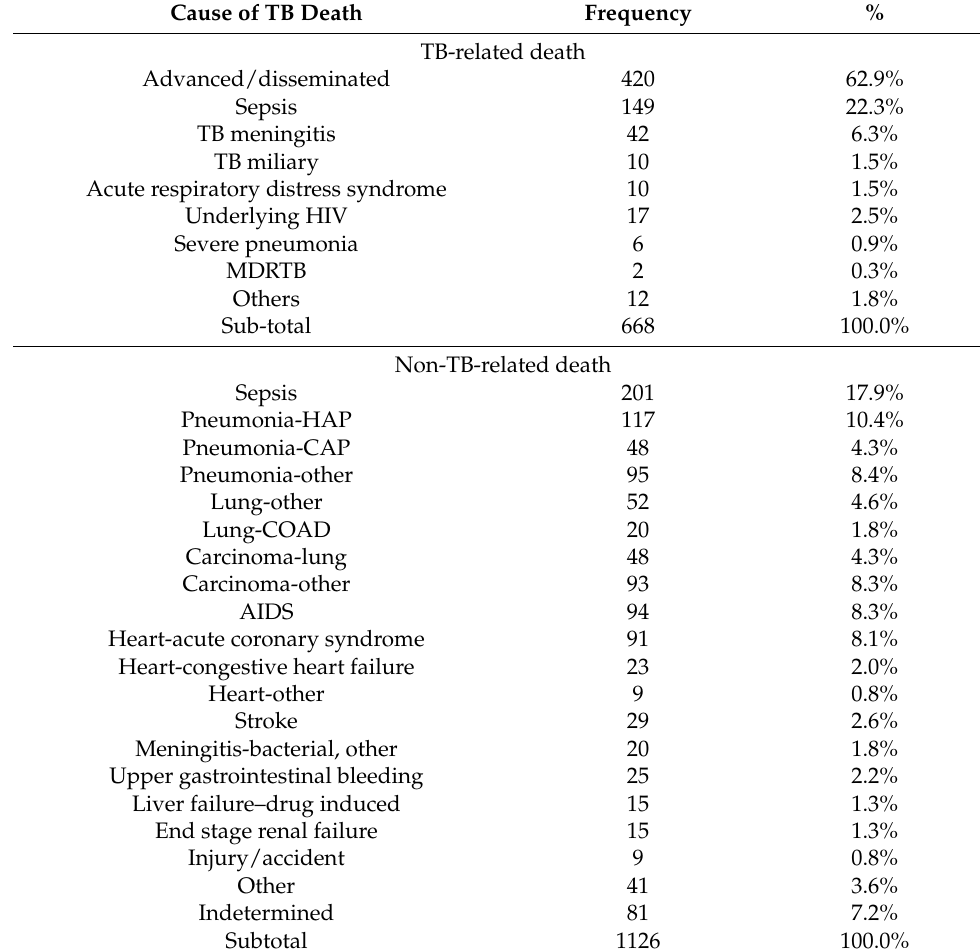
Table 4. Specific causes of TB-related and non-TB-related